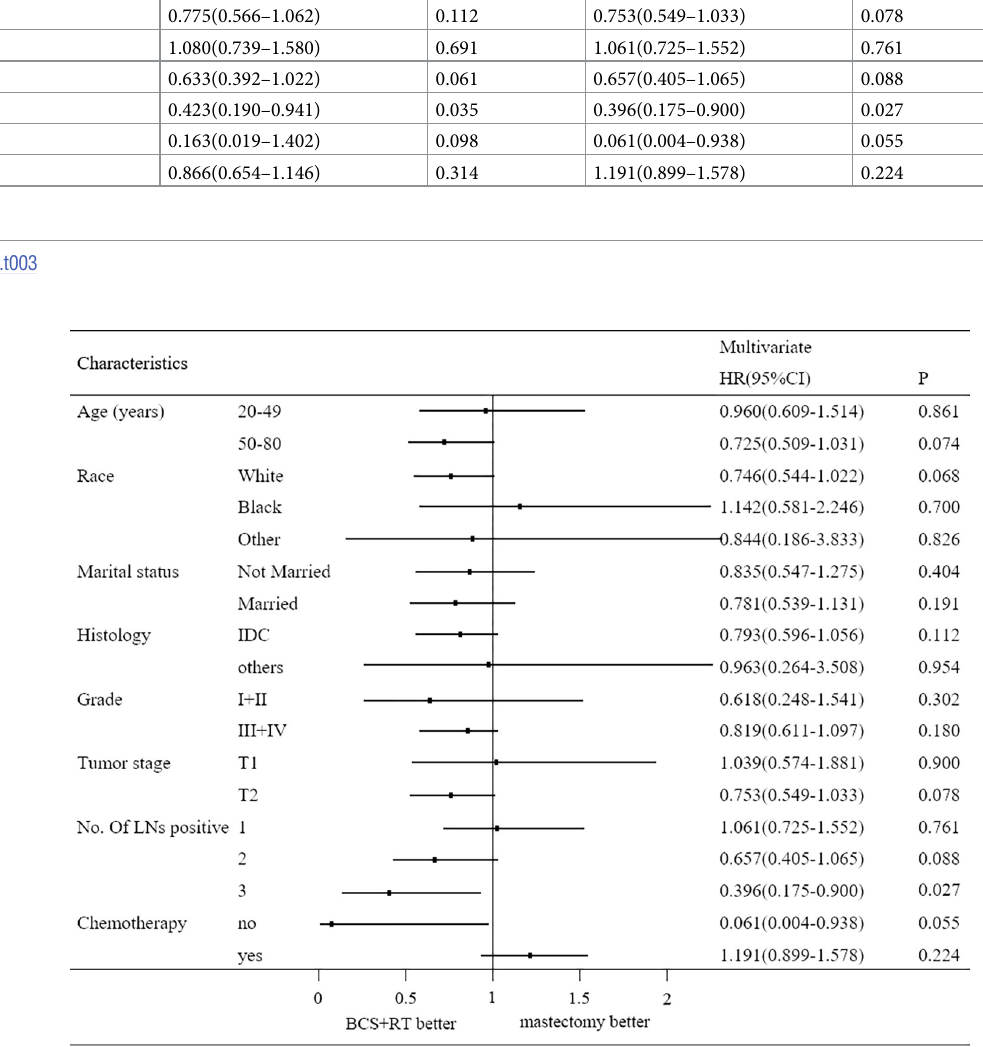
Fig 2. The forest plot of HR for BCSS in PMRT vs. no-PMRT group in subgroup analysis.